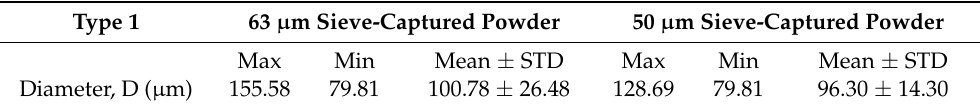
Table 3. Analysis of coarse agglomerate (Type 1) particle geometry in relation to the maximum, minimum and mean